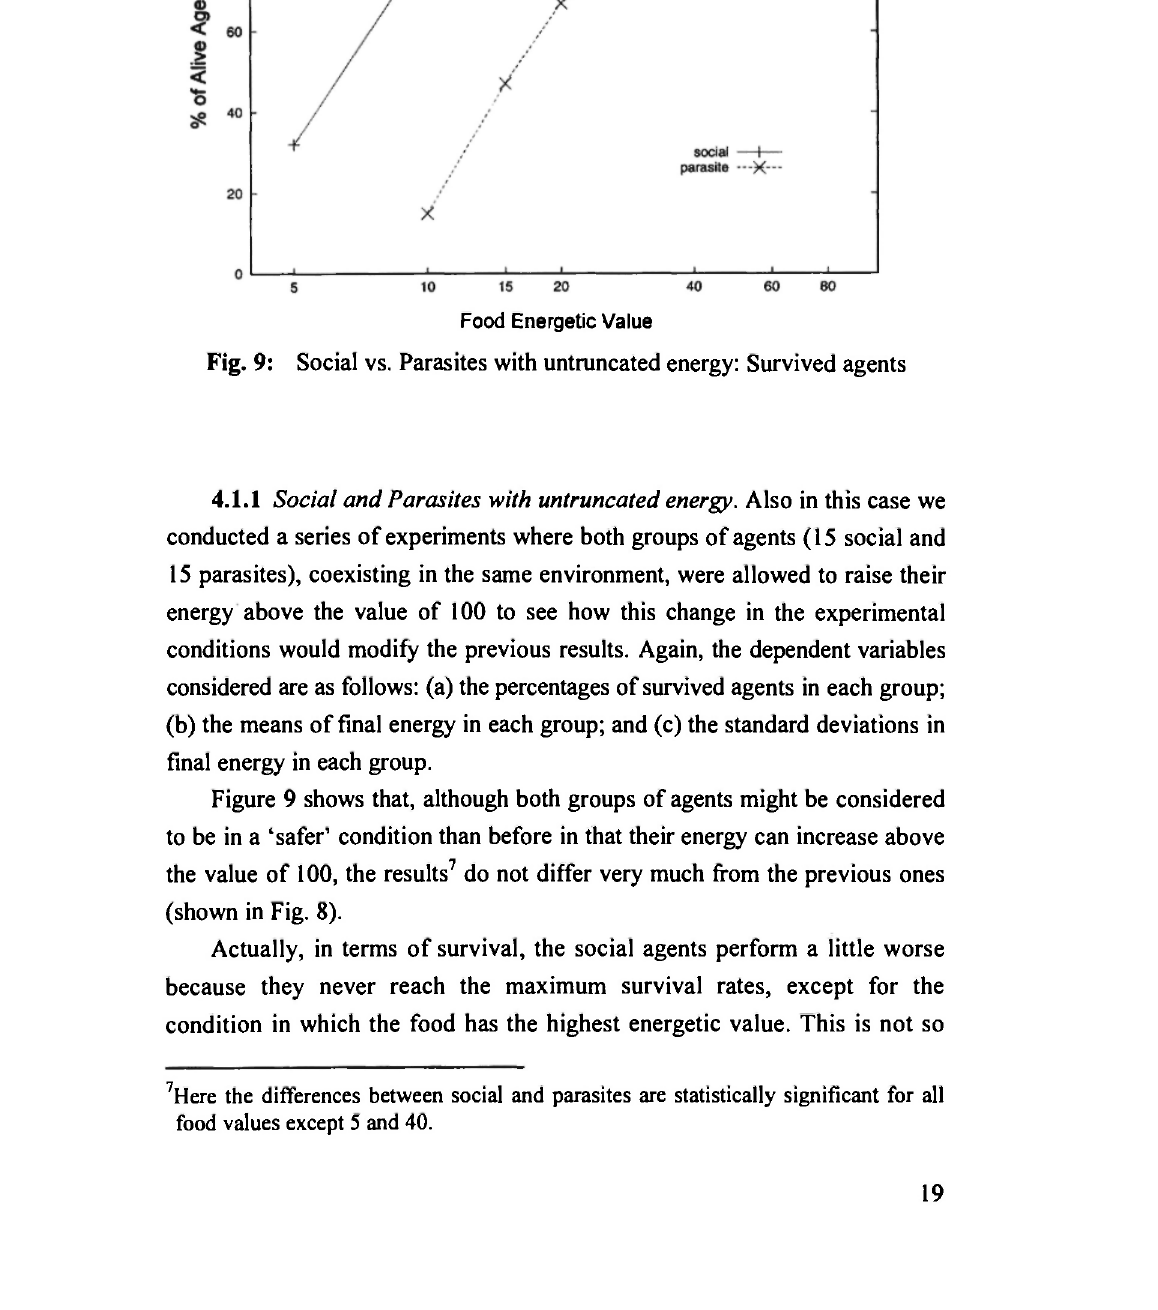
4.1.1 Social and Parasites with untruncated energy. Also in this case we